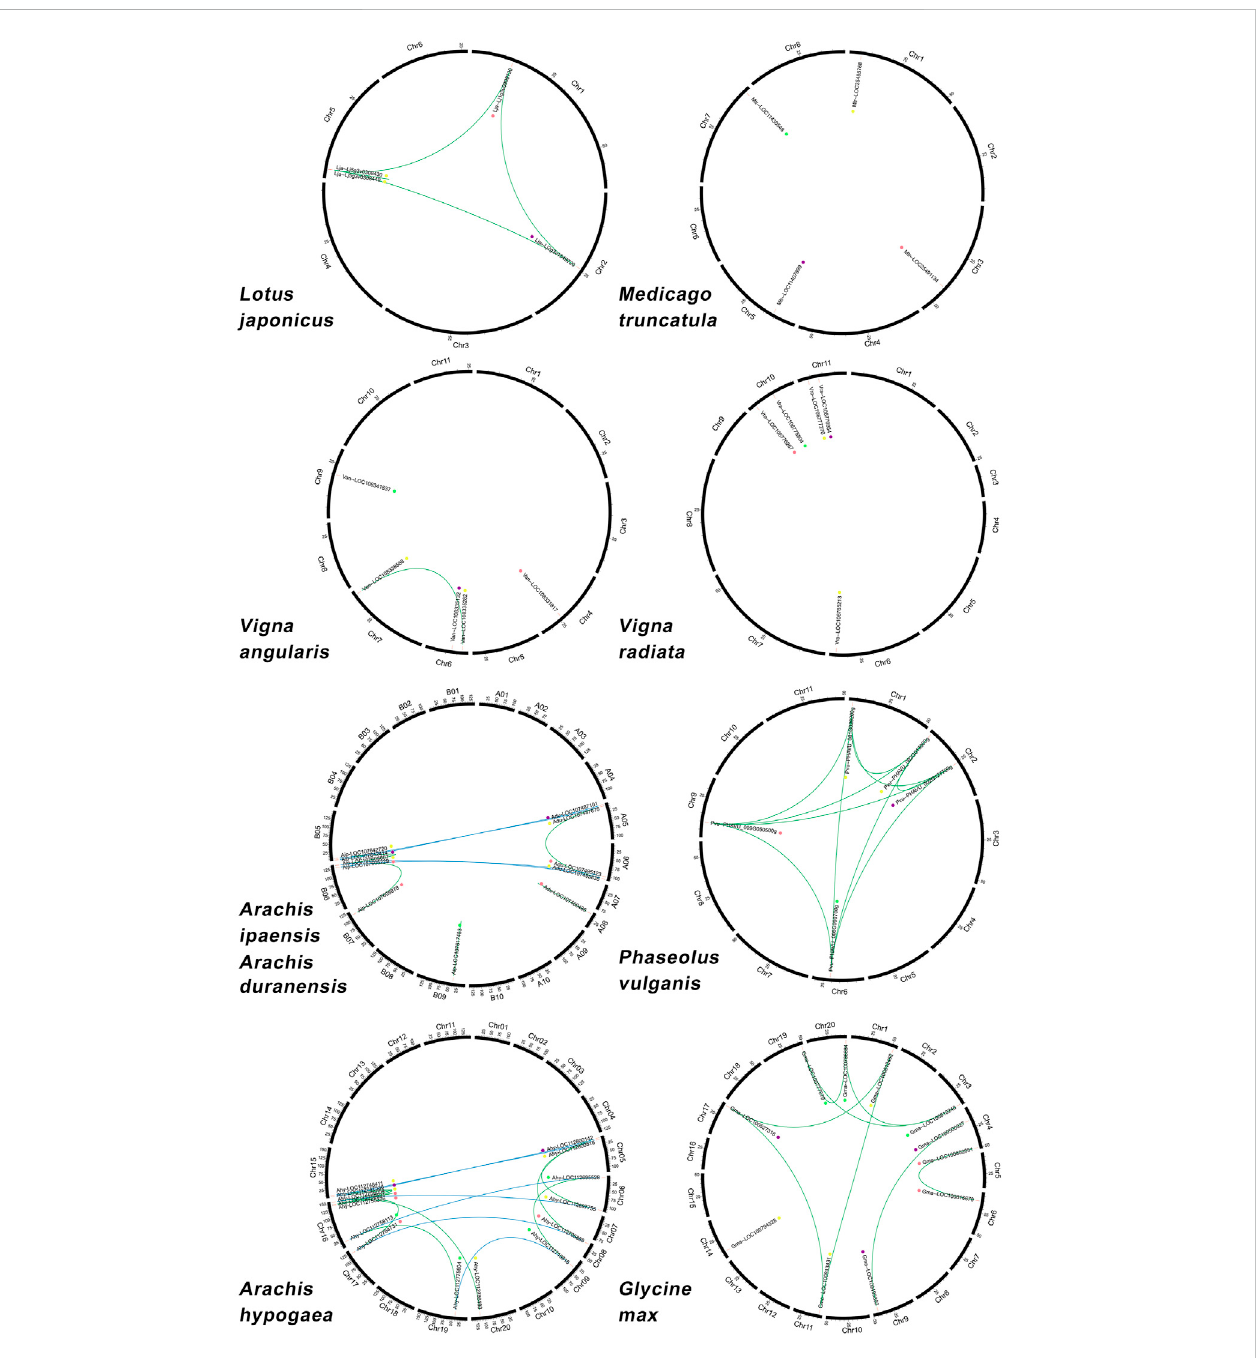
FIGURE 3 Chromosomal distribution and gene duplications of the legume ACBPs. The scales on the circle are in Megabases. Each black bar represents a chromosome, and the number at the bottom of each chromosome represents the chromosome number. Green and blue lines indicate duplication events in these nine legumes, respectively. Gene names are labeled based on their positions on the chromosomes. The colored dots indicate different subgroups: the purple is class I, the red is class II, the yellow is class III, the green is class